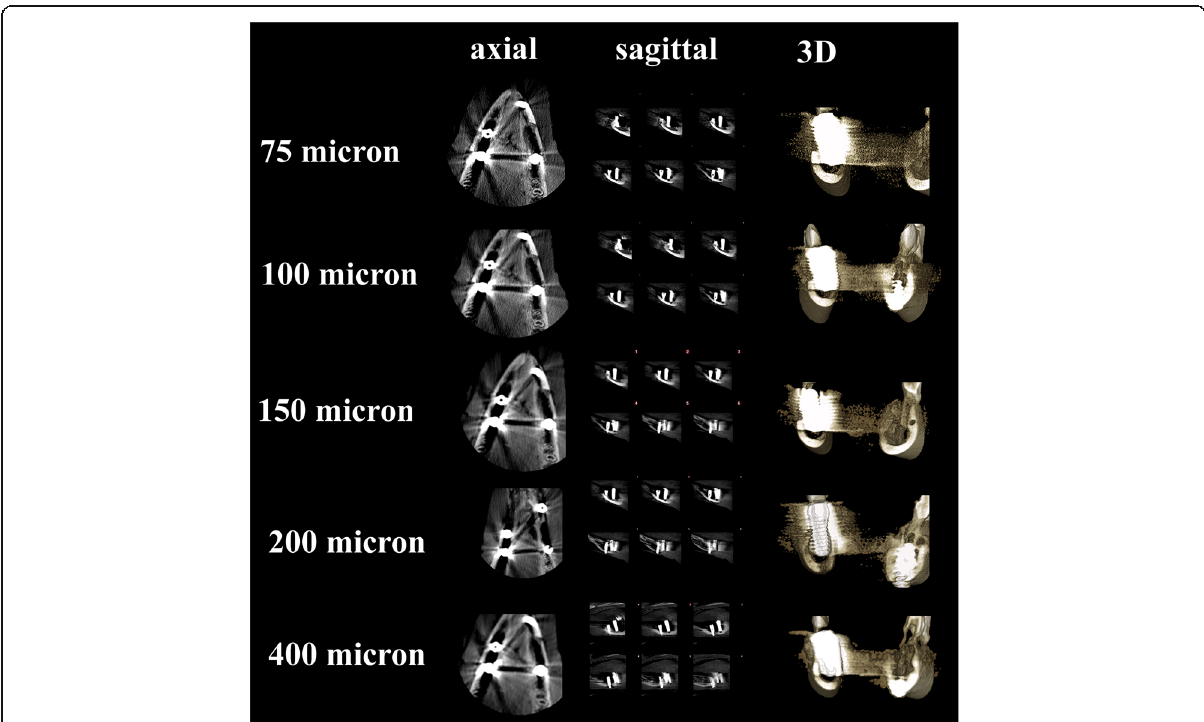
Fig. 3 Axial, sagittal and 3D slices from CBCT images of zirconium implants with simulated peri-implant fenestration defects with five voxel